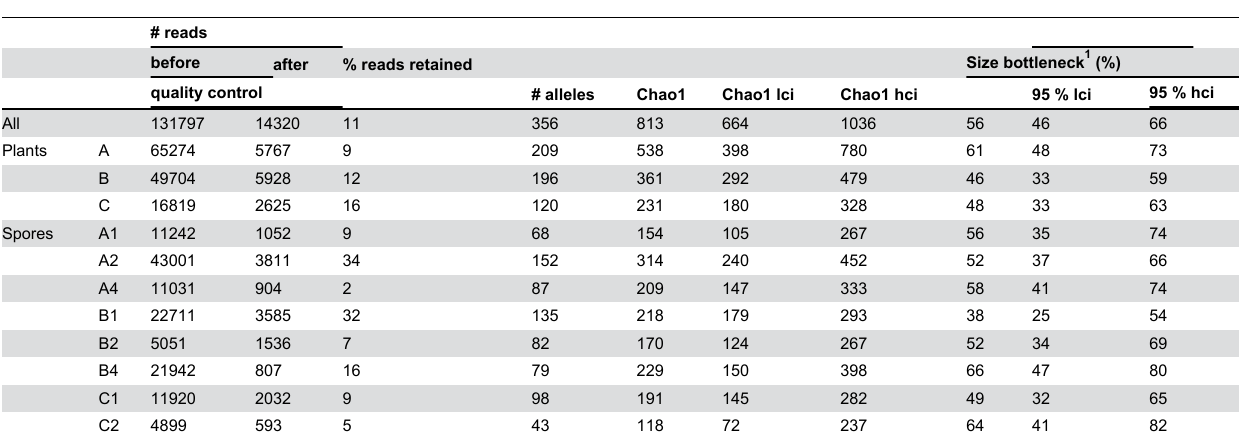
Table 1. Diversity estimates for the 2 nd exon sequence of PLS